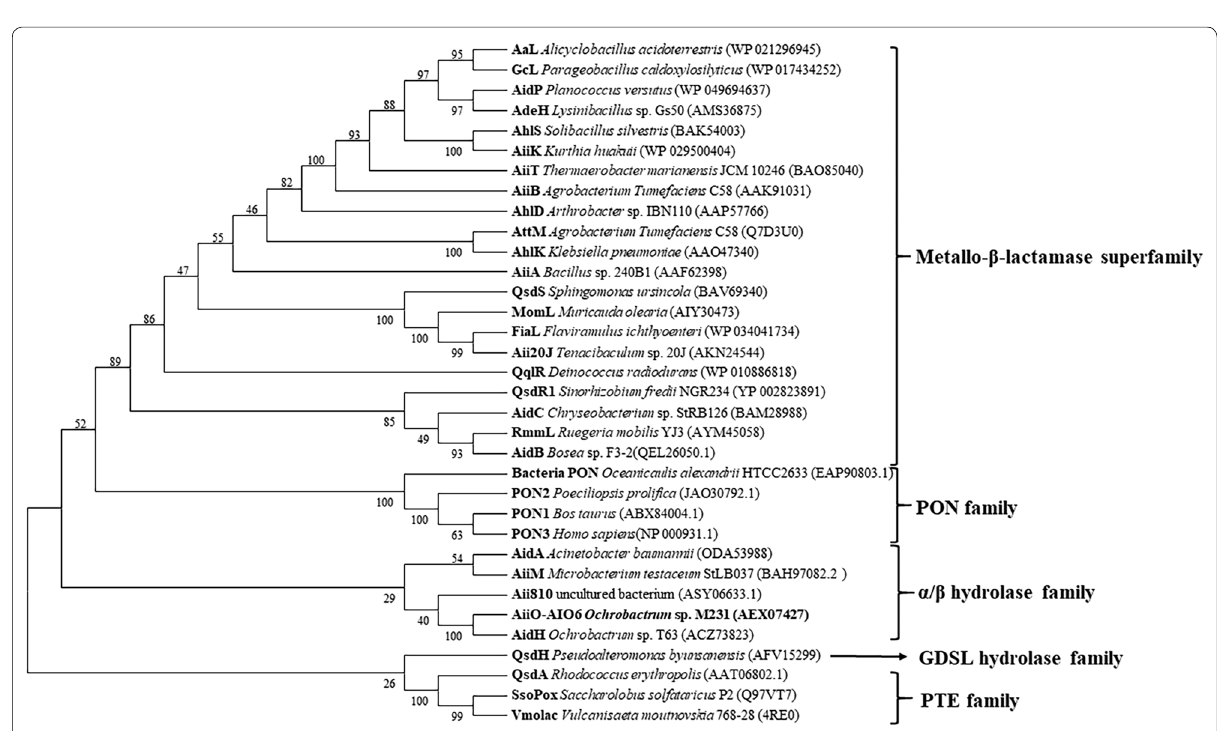
Fig. 6 Phylogenetic tree of AiiO‑AIO6 and the known lactonases. The phylogenetic analysis was constructed by the neighbor‑joining method with the ClustalW (MEGA7). Bootstrap values from 1000 replicates are given on the